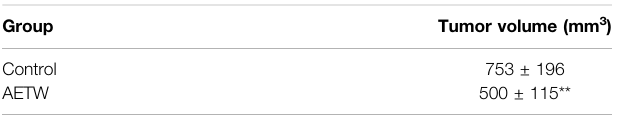
Compared with the control group, ** p <